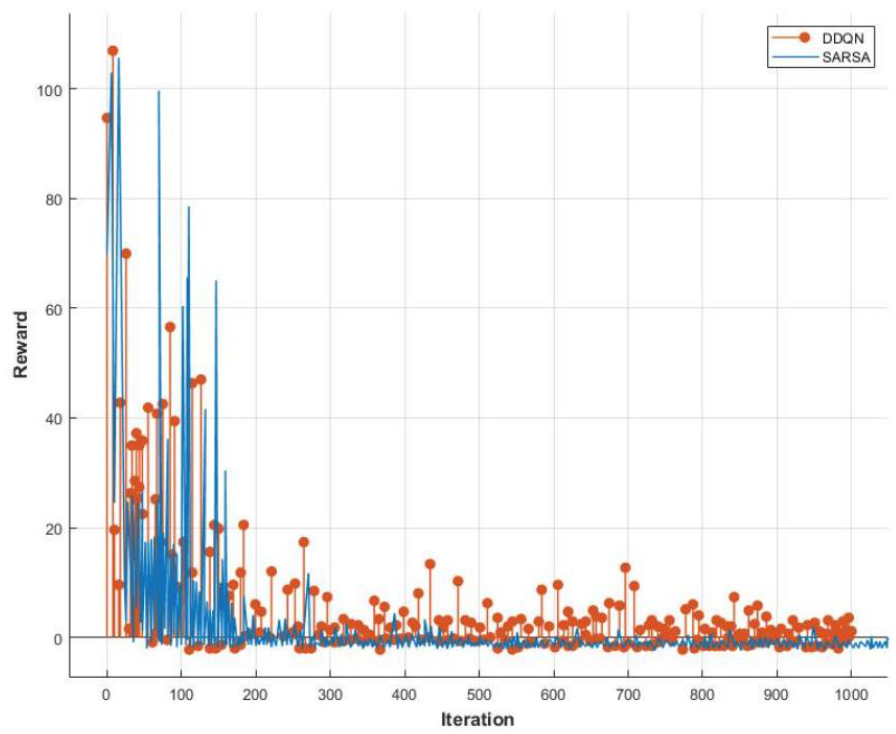
Figure 11. Convergence performance of the two RL-proposed algorithms.